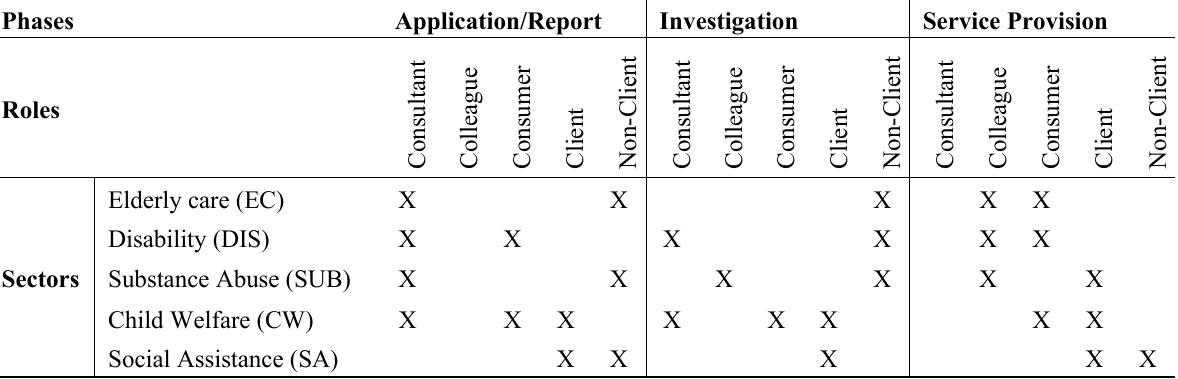
Table 1. The family’s roles in casework and clientification